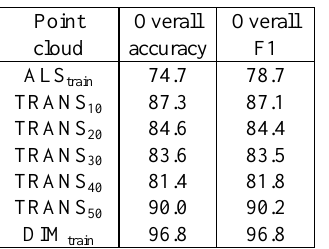
Table 3. Overall accuracy and overall F1-Score for DIM test [%]